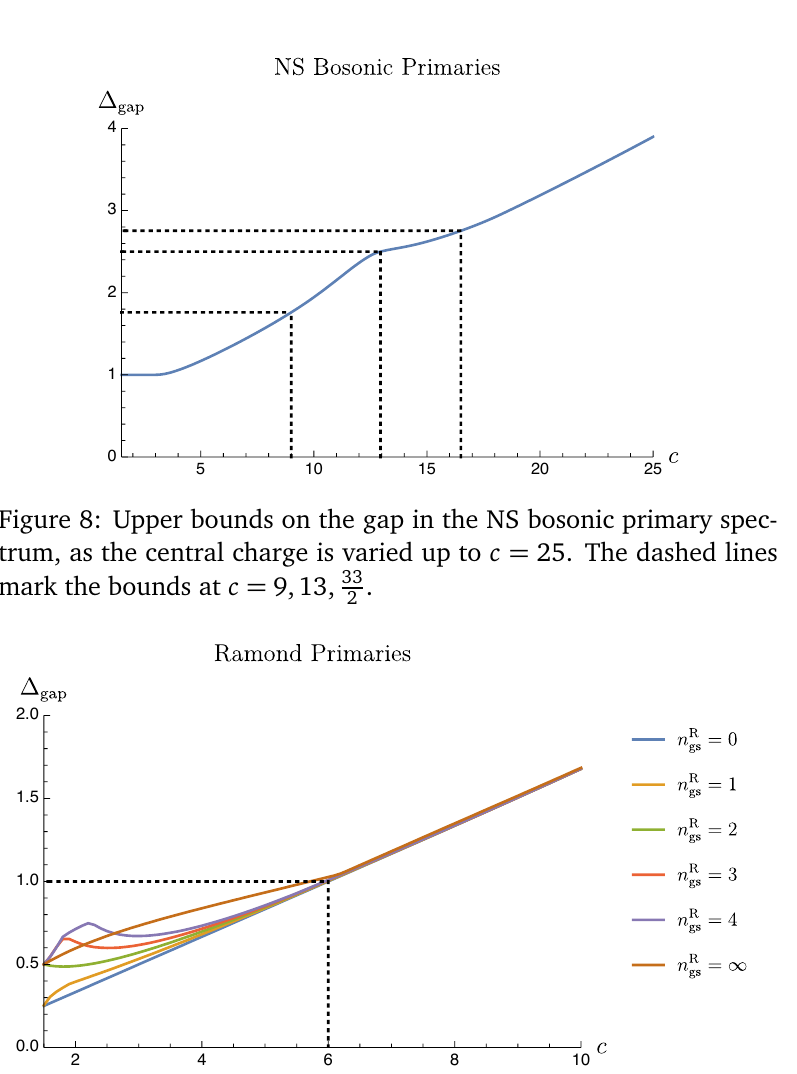
= 0,1,2,3,4, ∞ , and as the gs